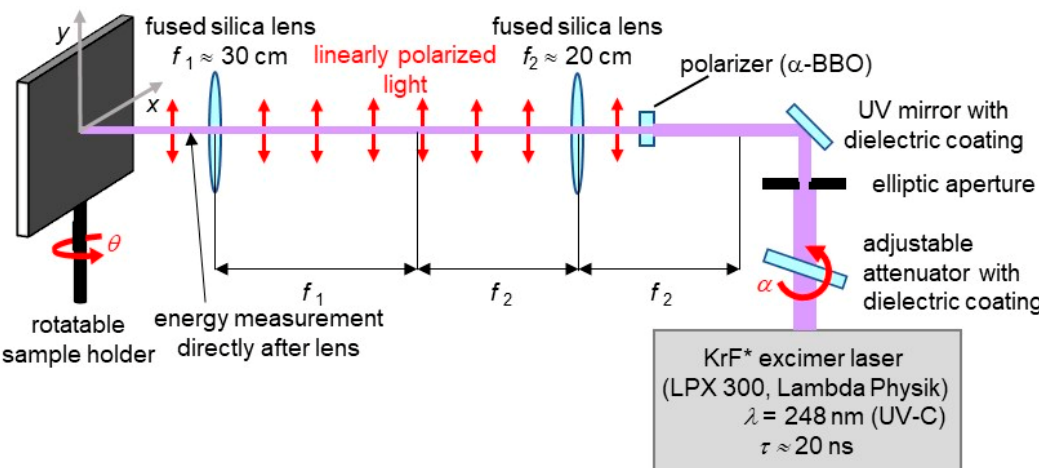
Figure 1. Setup for laser-induced periodic surface structures (LIPSS) fabrication on poly(ethylene terephthalate) (PET) foils by a KrF* excimer laser.